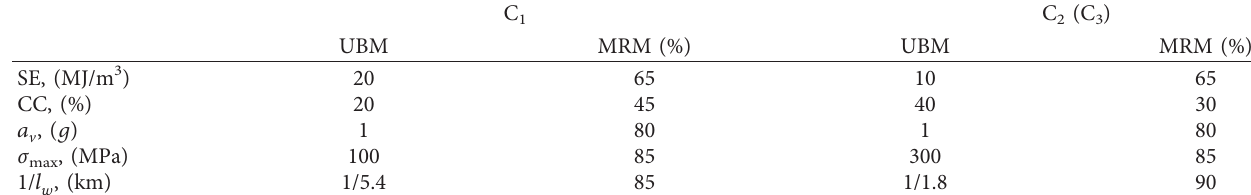
Figure 3: Rock-breaking phenomena captured in the tests. (a) C 1 –S 1 . (b) C 1 –S 2 . (c) C 1 –S 3 . (d) C 3 –S 1 . (e) C 3 –S 1 . (f) Wear surface of C 3. Table 3: UBM and MRM for the three specimens.